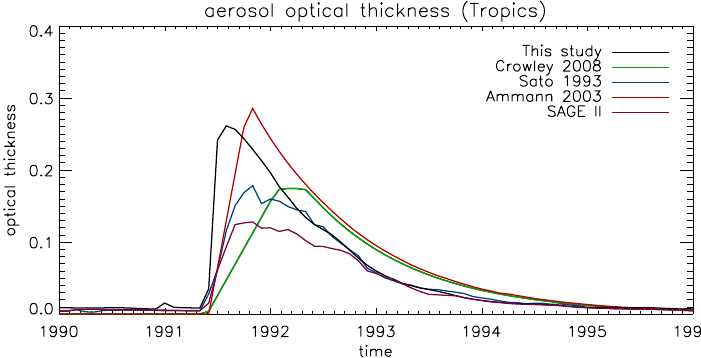
Fig. 14. Zonal mean total optical depth (AOD) in VIS (550nm) for the Pinatubo 1991 eruption for (a) 30 ◦ S–30 ◦